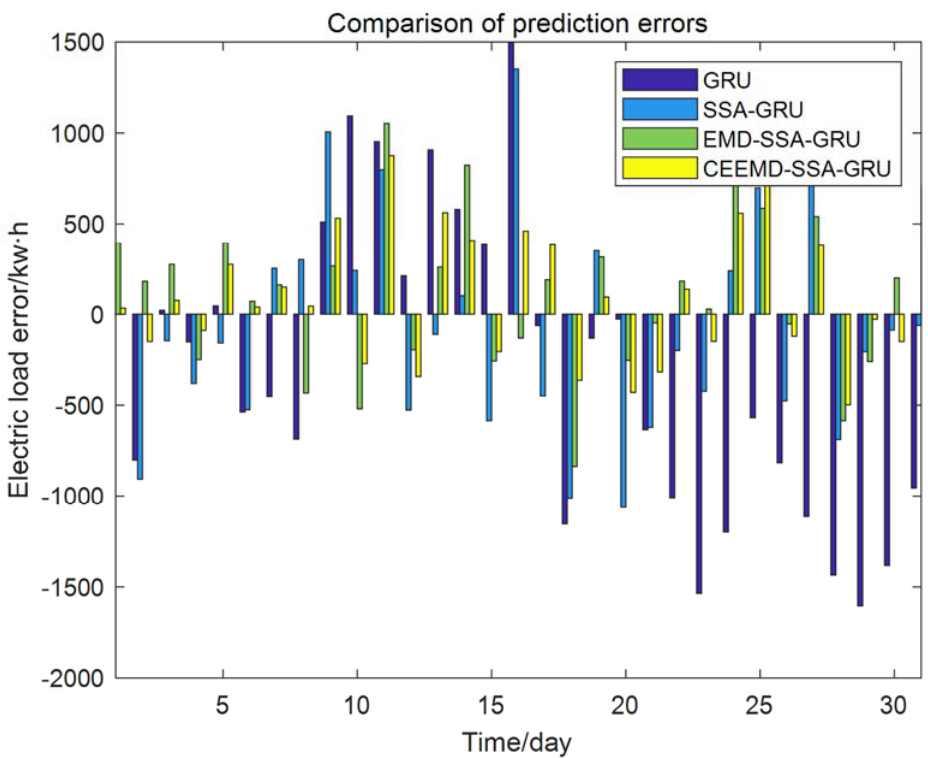
Figure 17. Comparison of prediction errors of four models. According to the calculation of error evaluation index formula, the comparison of various error evaluation indexes is shown in Table 6.